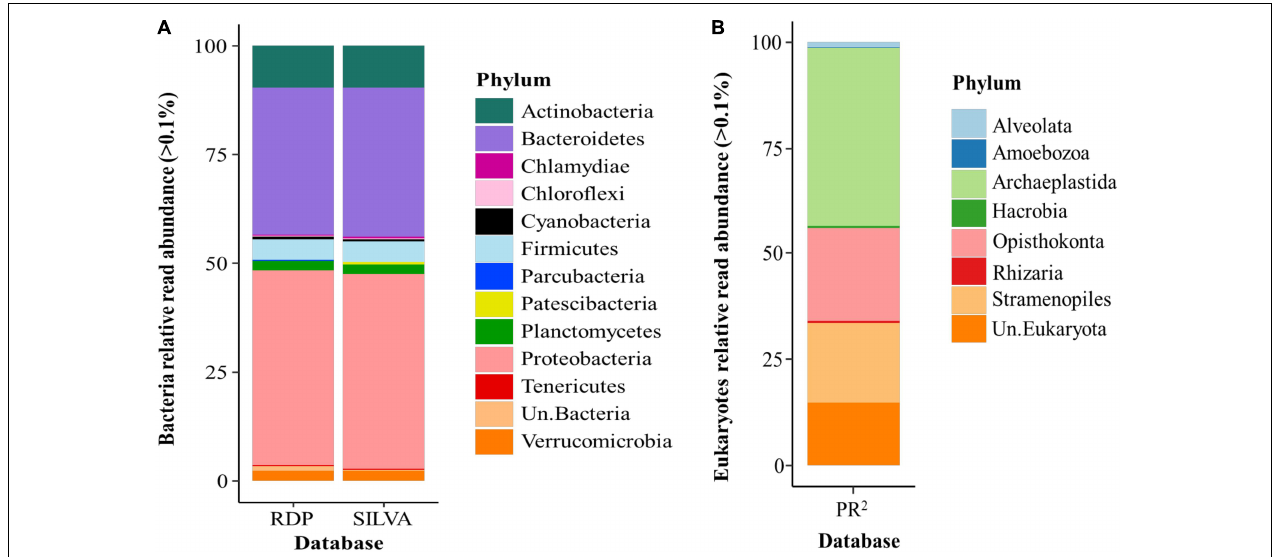
FIGURE 4 | Bacteria and eukaryotic phyla relative read abundance from different databases. (A) Relative read abundance of bacteria phyla from different databases (RDP and SILVA). (B) Relative read abundance of eukaryotes from PR2